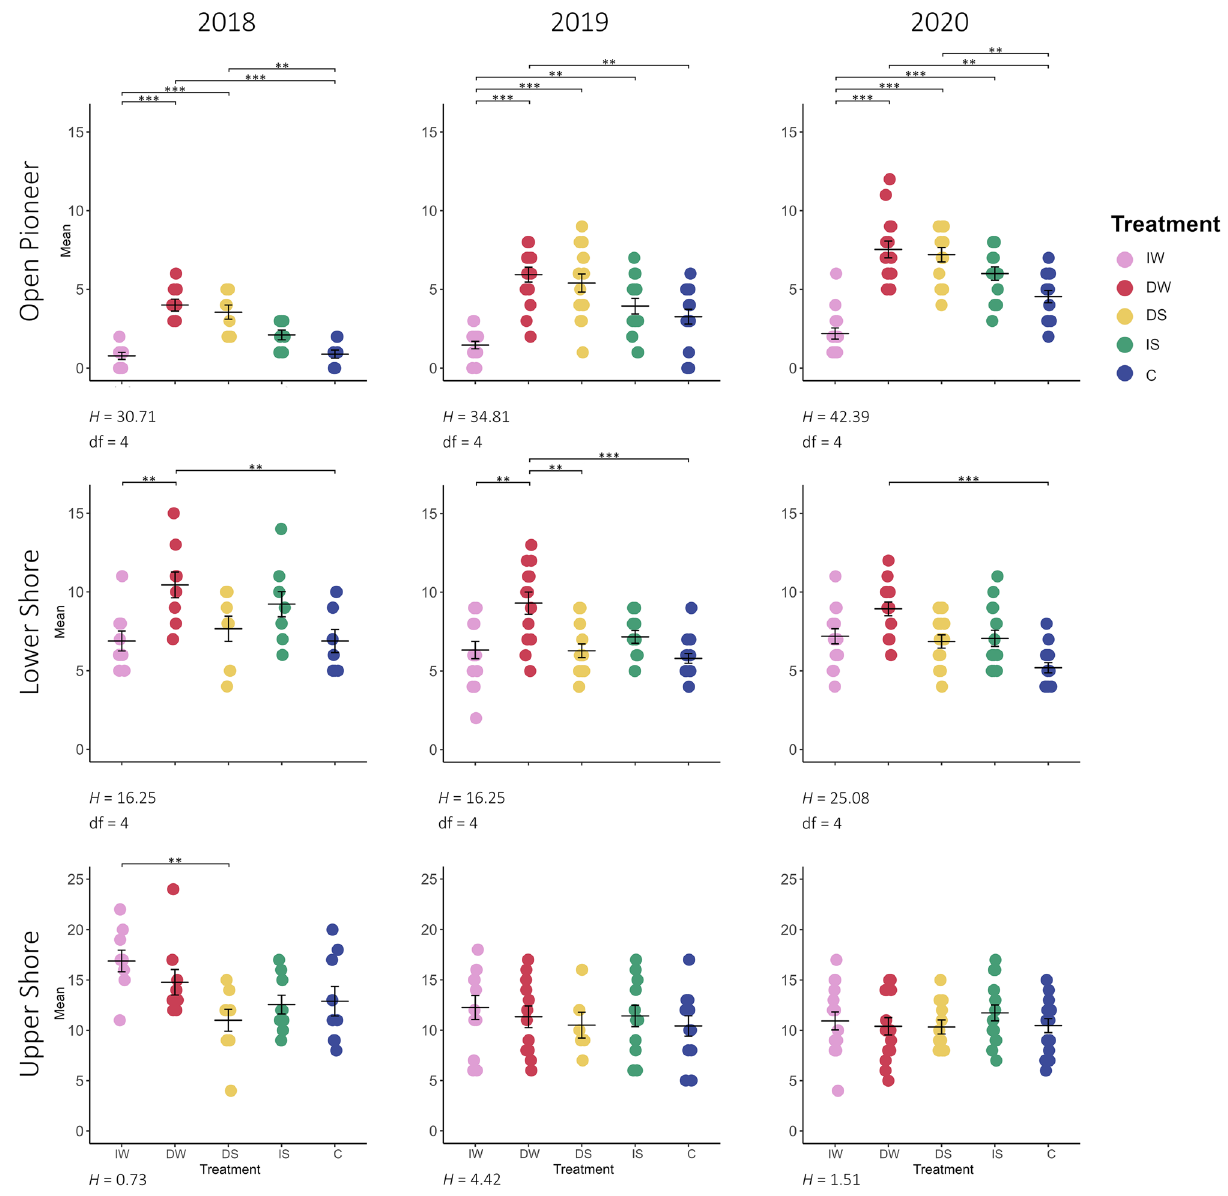
Figure 1. Number of species (species richness) per treatment in 2018, 2019 and 2020 for Open Pioneer, Lower Shore and Upper Shore communities. One dot represents an individual species. The cross represents the standard error (se) (vertical) and mean (horizontal), while horizontal bars indicate significant differences among treatments. The level of significance is coded as **p = 0.01, and ***p = 0.001. Differences in species richness between treatments were examined using Kruskal Wallis followed by Dunn’s post hoc test with Bonferroni adjustments in the years 2018, 2019 and 2020. Kruskal Wallis results are shown as H-value and degrees of freedom (df). Pink: increased water level (IW); red: decreased water level (DW); yellow: decreased salinity (DS); green: increased salinity (IS); blue: control (C). See Table 2 for treatment details. More information can be found in the Supplementary Table S1, Supplementary Figs. S4, S5, and